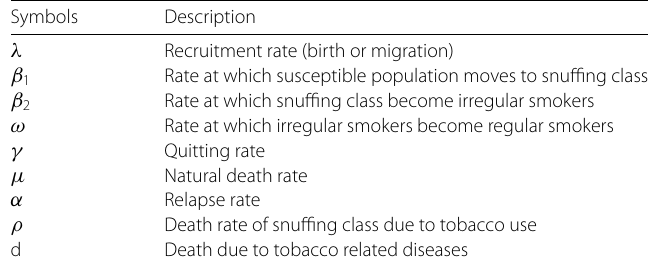
Table 1 Parameters and description